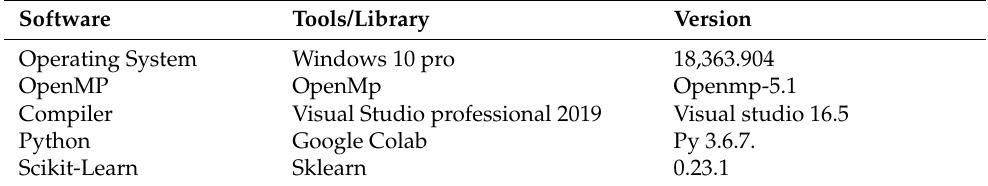
Table 4. Software